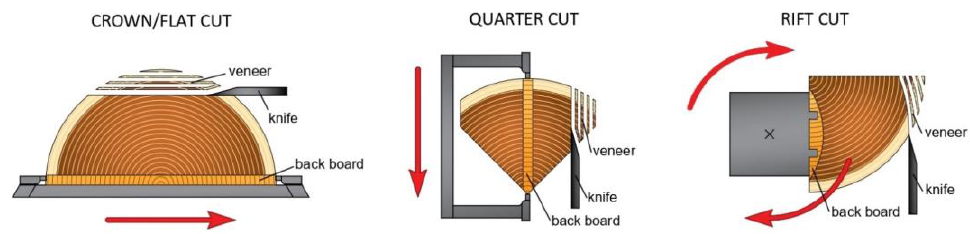
Figure 1. Veneer cutting methods (© Domagoj Mamić, 2022).